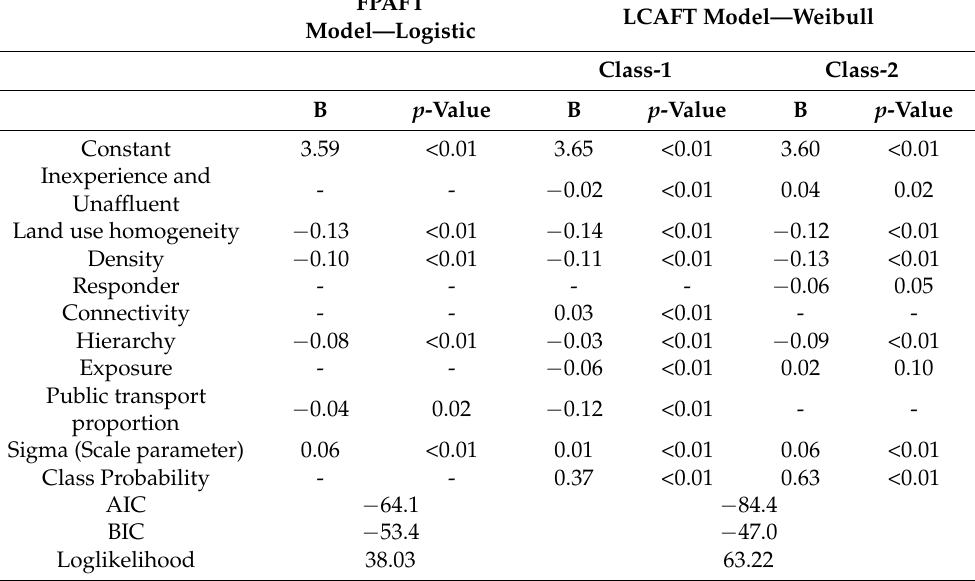
Table 3. Crash duration model estimation